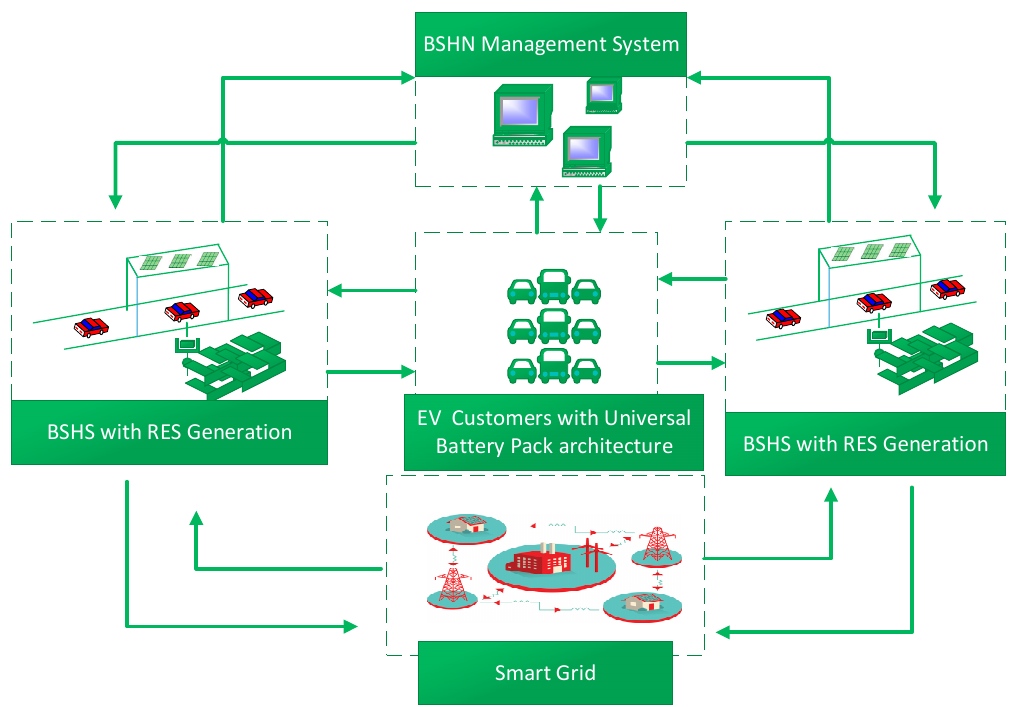
Figure 13. Battery sharing network (BShN) communication Interface between components and the smart grid.